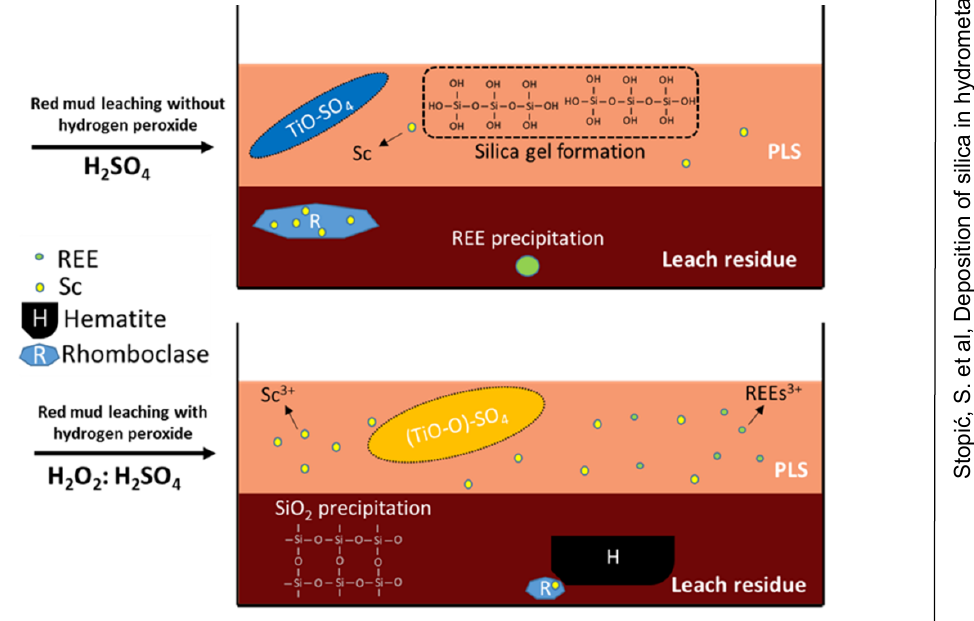
Figure 2 – Silica gel formation mechanism and precipitation (Alkan et al, 2019, pp.266- 272) Рис . 2 – Механизм гелеобразования из диоксида кремния и выделение осадка (Alkan et al, 2019, pp.266-272) Слика 2 – Механизам формирања гела од силицијум - диоксида и преципитација (Alkan et al, 2019,